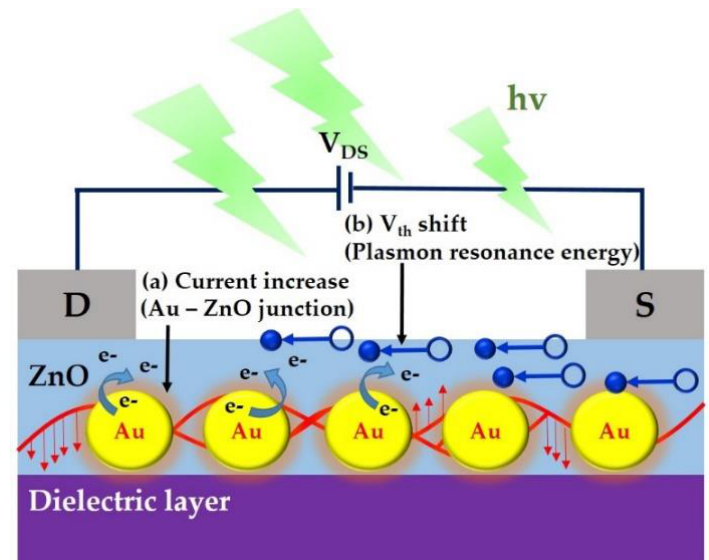
Figure 5. Mechanism of visible-light induced photocurrent and energy-band modification on the hybrid junction of metallic AuNPs and semiconducting ZnO film.